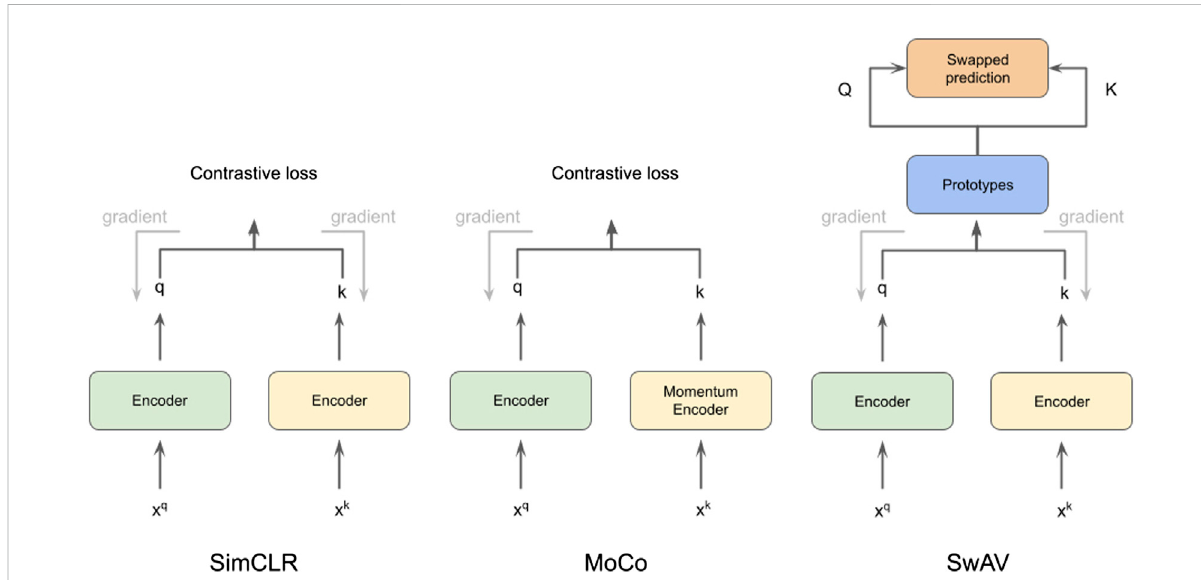
FIGURE 1 IllustrationofmethodsSimCLR(Chenetal.,2020a),MoCo(Heetal.,2020)andSwAV(Zhuetal.,2020),whichweuseforcryo-ETsubtomogram classi fi cation.